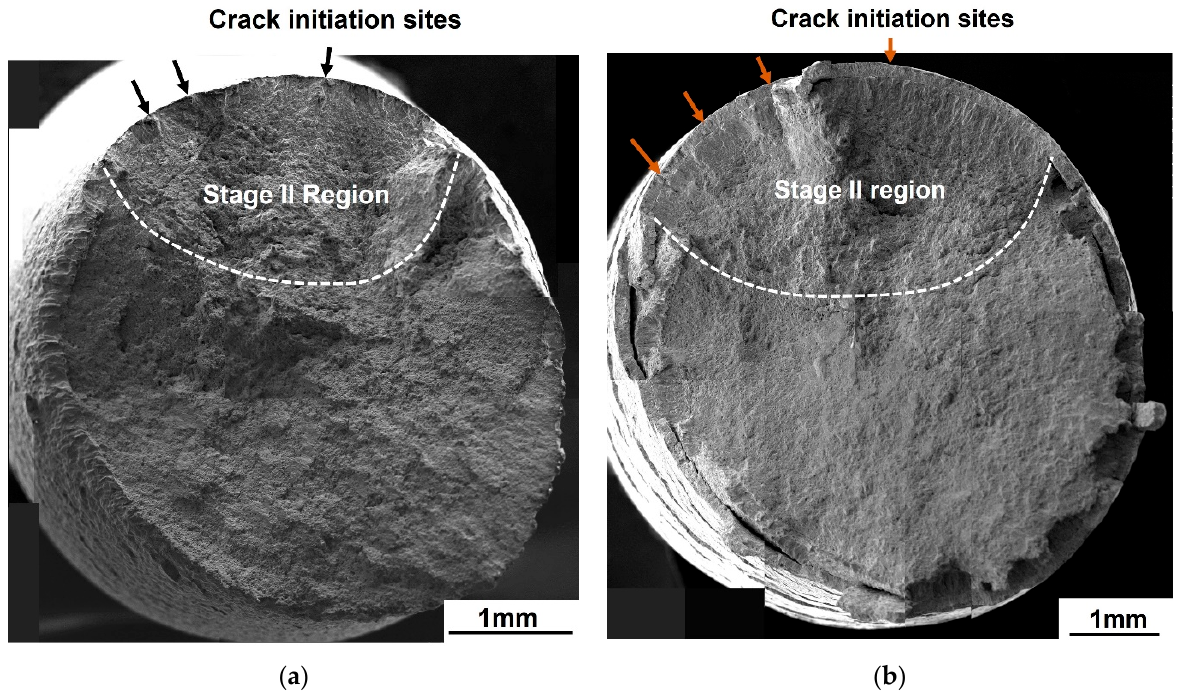
Figure 8. Fatigue fracture surfaces of normalized AISI 1020 steel in the low cycle fatigue at R = 0.01: ( a ) non-galvanized, σ max = 389.6 MPa and ( b ) galvanized, σ max = 346.4 MPa.